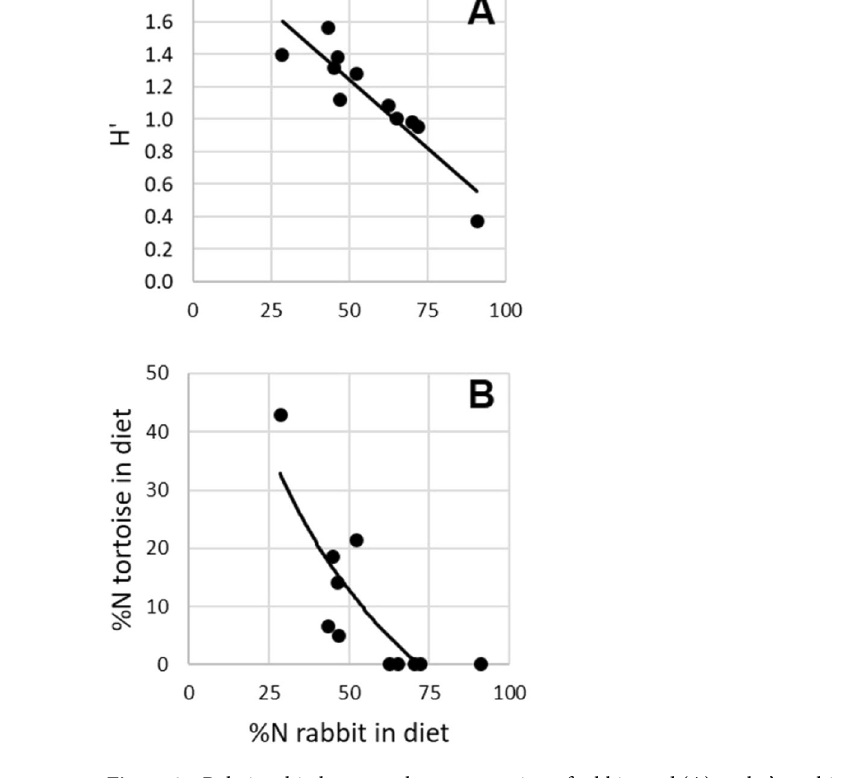
Figure 3. Relationship between the consumption of rabbits and ( A ) eagles’ trophic diversity (Shannon–Weaver index, H’) and ( B ) tortoise consumption in the 11 golden eagle territories of the study area with sufficient diet sample size. In both cases, the inverse relationship was significant (see text for more